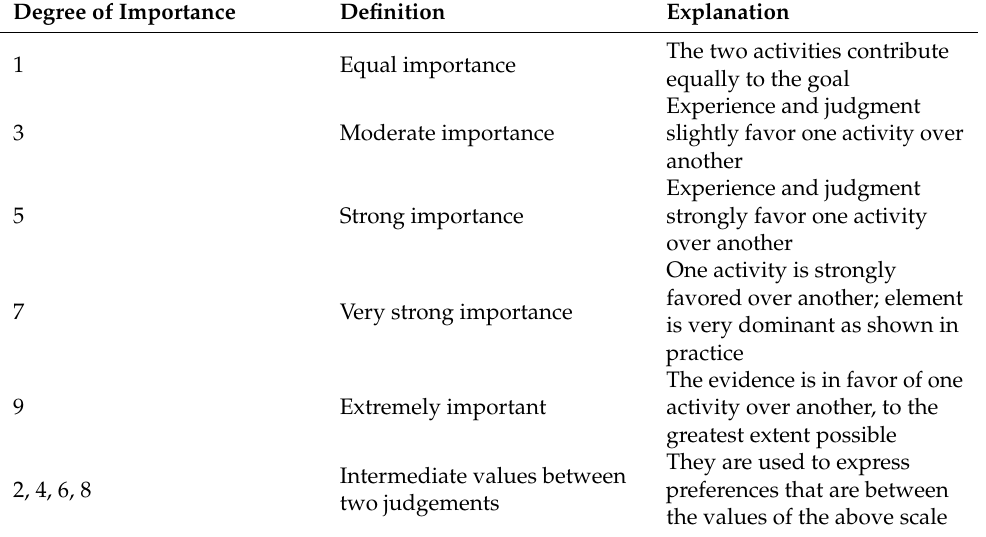
Table 3. Saaty fundamental